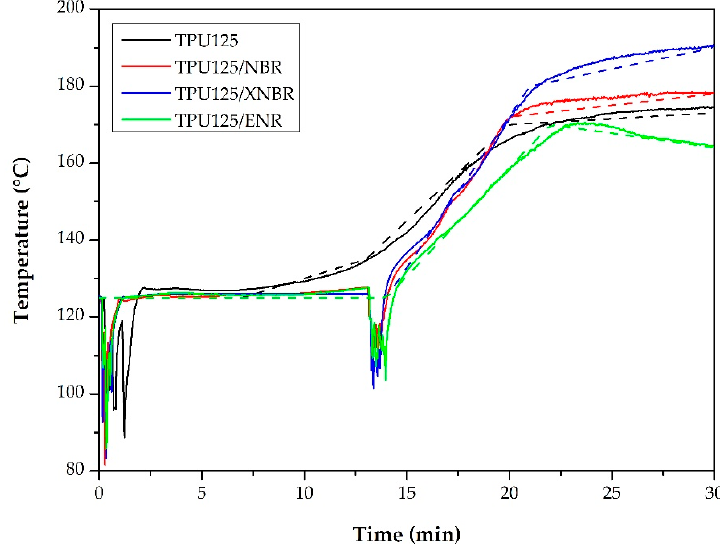
Figure 6. The real temperature profiles recorded during the production of TDVs (——) and the approximate curves (– – –) that were used for the investigation of the polymerization tests of the matrix TPU.